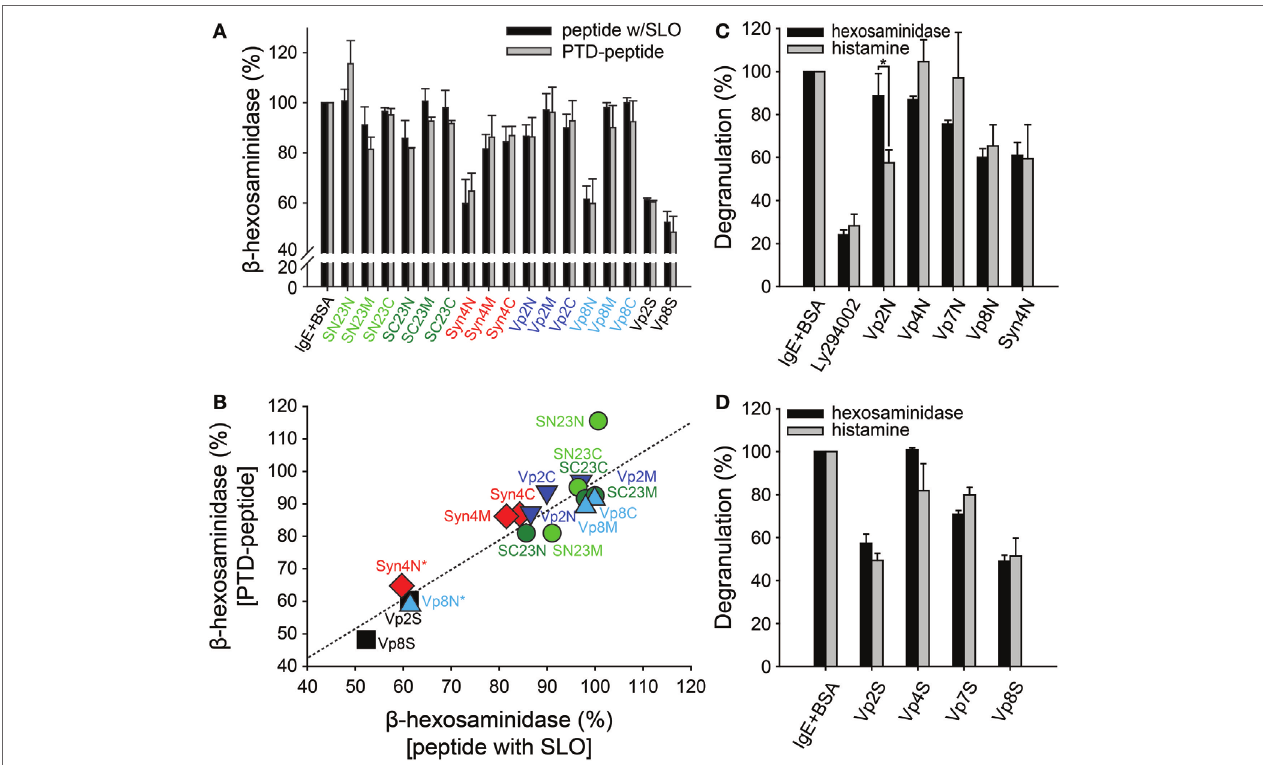
FigUre 2 | Effect of synthetic peptides on the degranulation of RBL-2H3 mast cells. (a) RBL-2H3 mast cells grown on 24-well plates were treated with dinitrophenyl (DNP)-specific IgE and then exposed to the synthetic peptides (10 µM) together with streptolysin-O (SLO). After incubation for 30 min, the cells were stimulated with 2,4-dinitrophenylated bovine serum albumin (DNP-BSA) for degranulation. For comparison, protein transduction domain (PTD)-conjugated synthetic peptides were tested in the same manner as described above without SLO treatment. The soluble domains of vesicle-associated membrane protein 2 and 8 (Vp2S and Vp8S) were included in the experiment as positive controls. (b) Correlation between the results of degranulation from the synthetic peptides with SLO and the PTD-conjugated peptides without SLO. (c,D) The inhibitory effects of the synthetic peptides on the mast cell degranulation of distinct granule subsets. Mast cells sensitized with DNP-IgE were treated with PTD-conjugated peptides (c) or soluble proteins (D) , followed by stimulation with DNP-BSA. Cell culture medium supernatants were assayed for the detection of degranulation. LY294002 was used as a positive control inhibitor of Fc ε RI-mediated degranulation in mast cells. All data are presented as the mean ± SD from three independent experiments. The statistical significance of differences was evaluated by analysis of variance (* p <